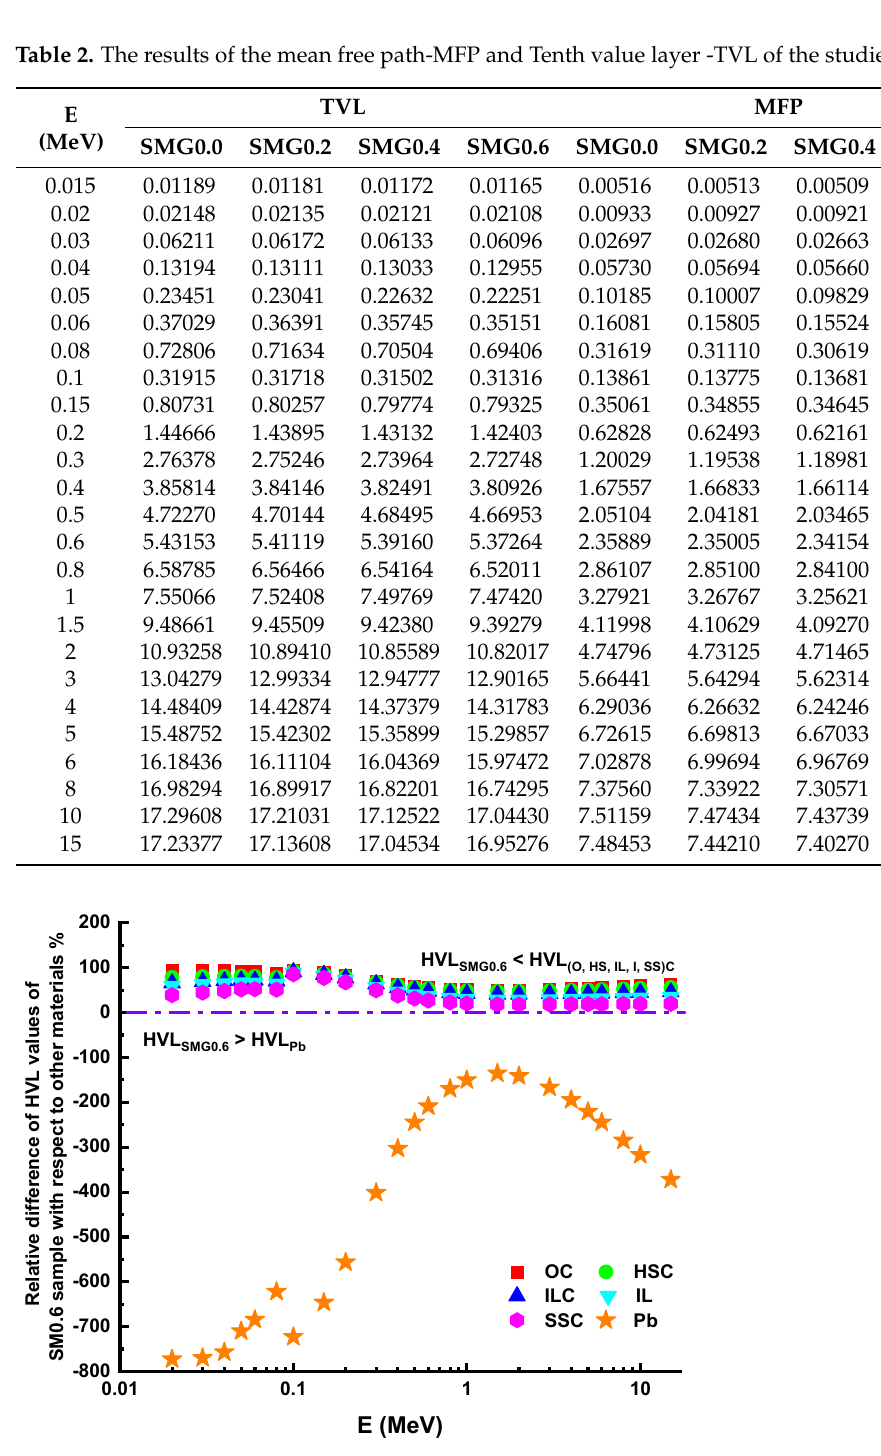
Figure 13. HVL relative differences of SM0.6 sample and HVL relative differences of other materials. The Z eff values, dependent on the photon energy of the examined glass samples, are given in Figure 14. Z eff values indicate the radiation absorption capacity of a glass